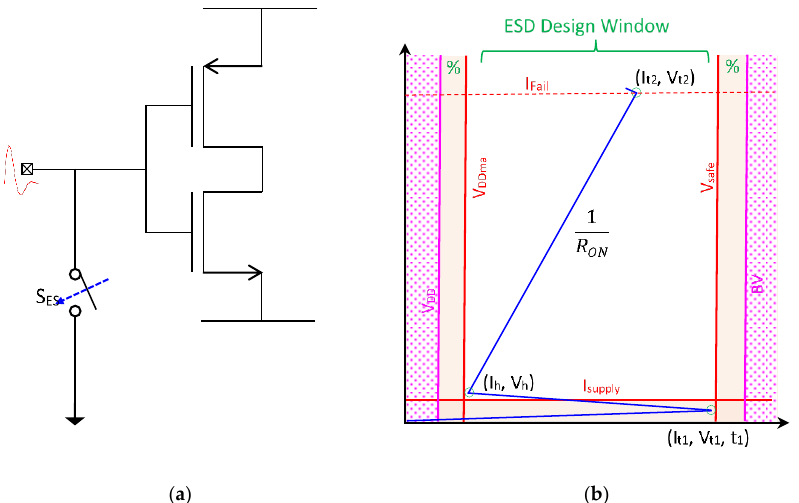
Figure 15. ESD-protection device concept and ESD design window: ( a ) ideal ESD-protection switch, and ( b ) ESD design window showing ESD-critical parameters.